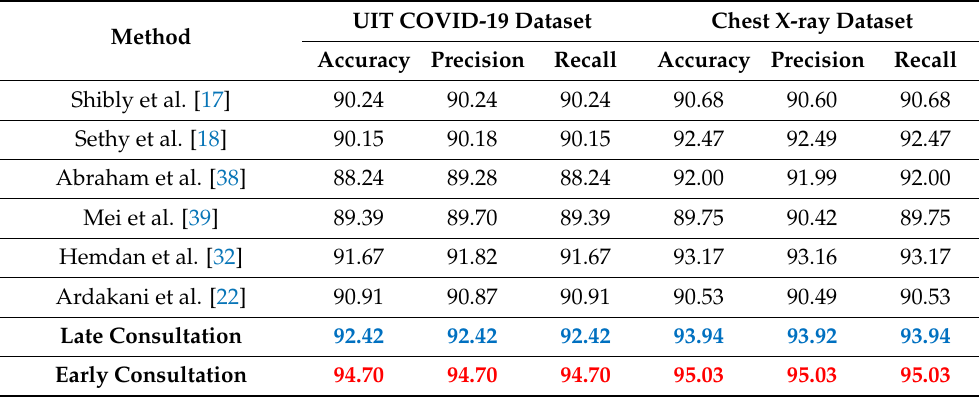
Figure 3. Visualization of the prediction results of various models (best viewed online in color with zoom). From top to bottom: ResNeXt101, ResNet152, DenseNet201, HRNet-W48, late consultation, and early consultation. Incorrect predictions are marked with a red rectangle. Table 6. Comparison with state-of-the-art baselines. The top-two methods are marked in red and blue ,